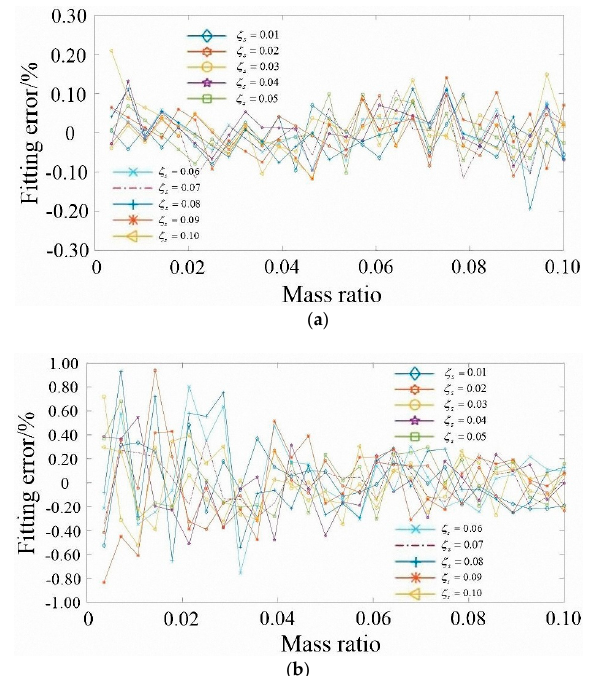
Figure 3. Comparison of fitting error of fitting formulas. ( a ) Comparison of optimum frequency ratio; ( b ) Comparison of optimum damping ratio.